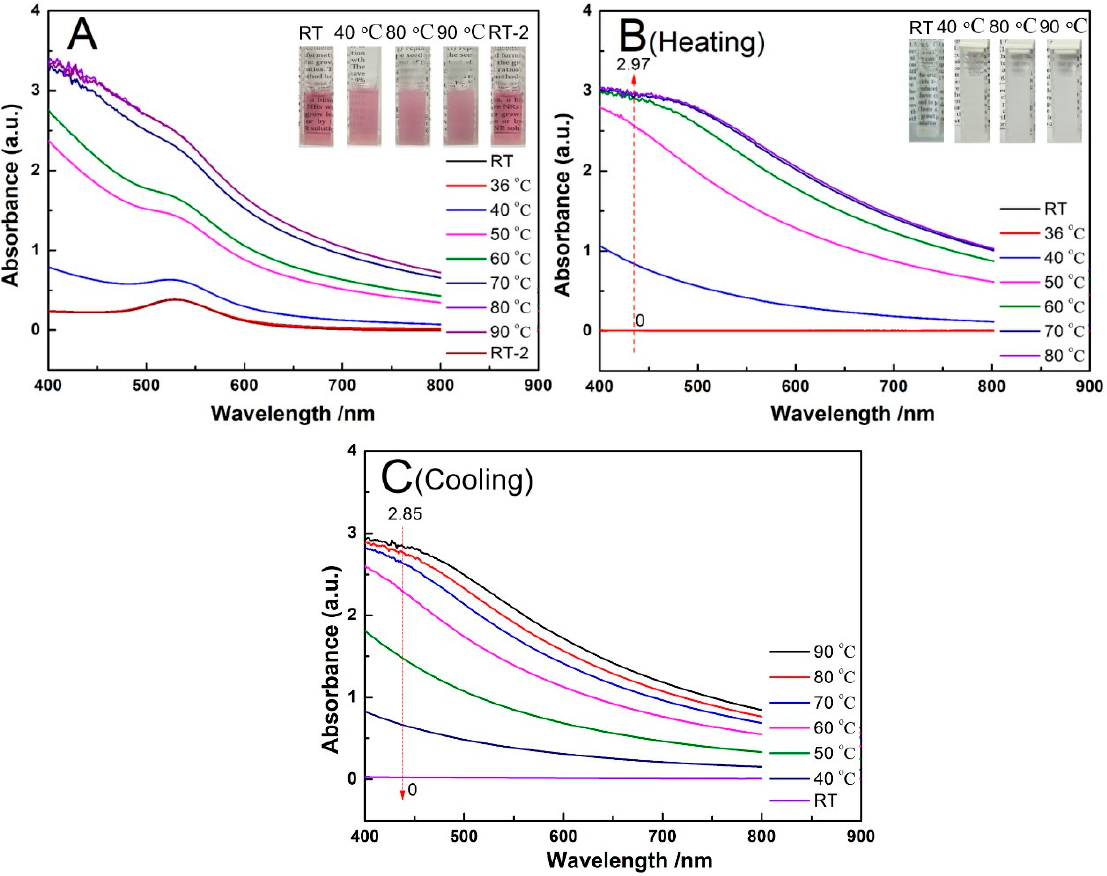
Figure 3. The change in the UV-Vis spectra with temperature for AuNPs-PNIPAM/PNIAM ( A ) and the supernatant from centrifugation of AuNPs-PNIPAM/PNIAM ( B , C ).